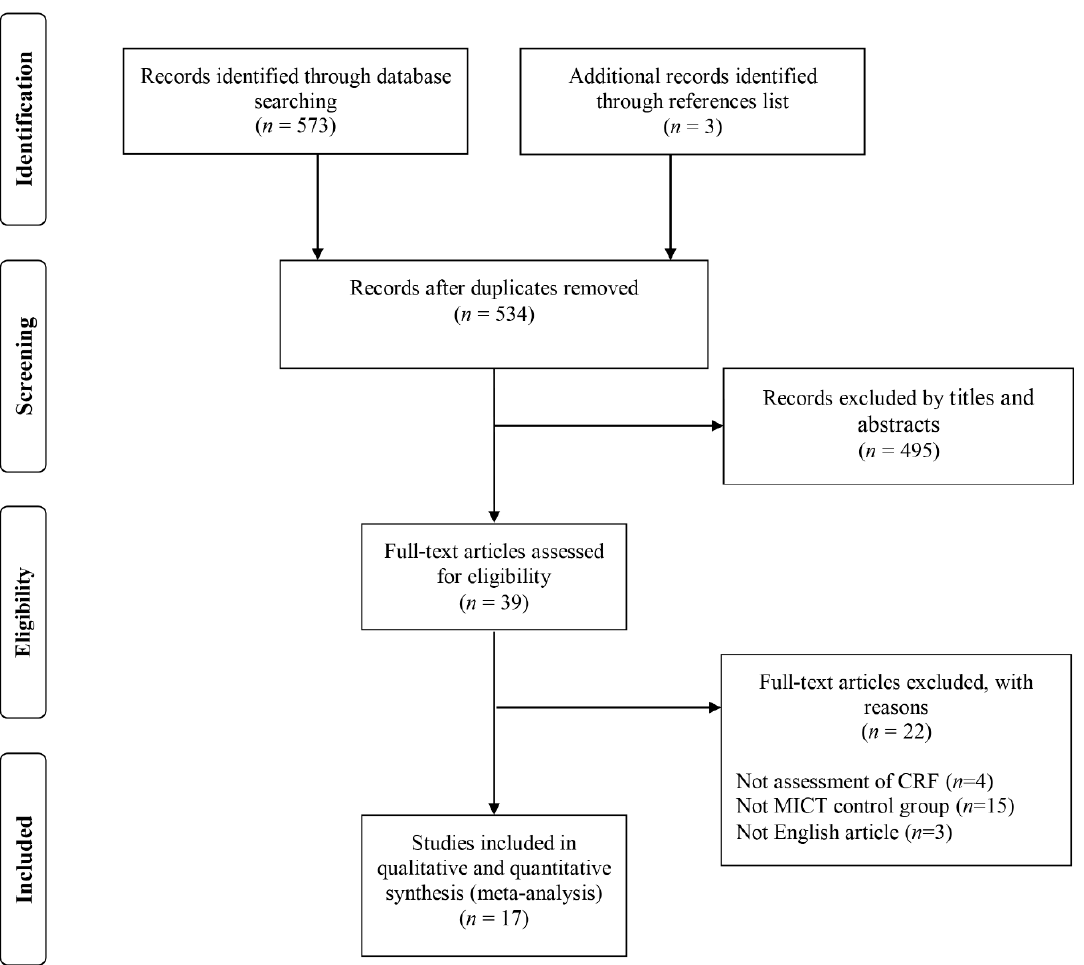
Figure 1. PRISMA (Preferred Reporting Items for Systematic Reviews and Meta Analyses) Flow diagram of the study selection process.